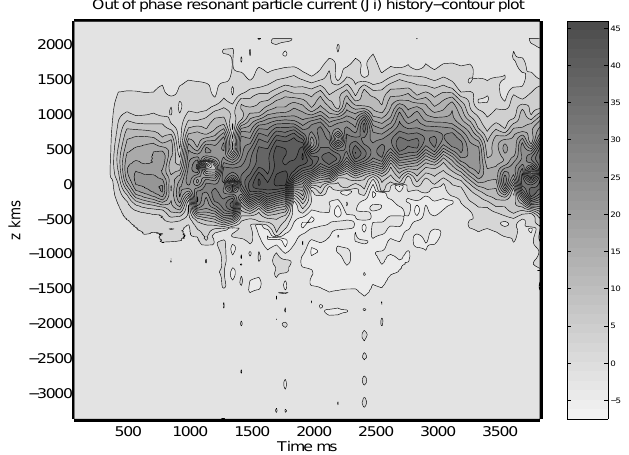
Out of phase resonant particle current (Ji) history−contour plot